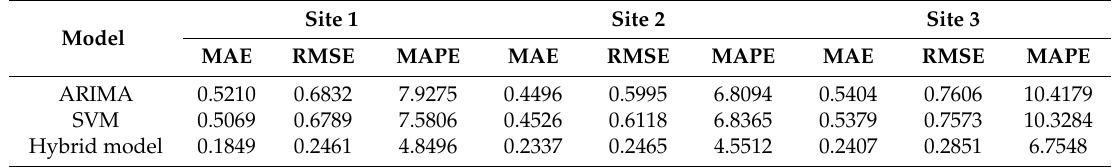
Table 5. The results of the hybrid model, ARIMA and SVM model at three sites.